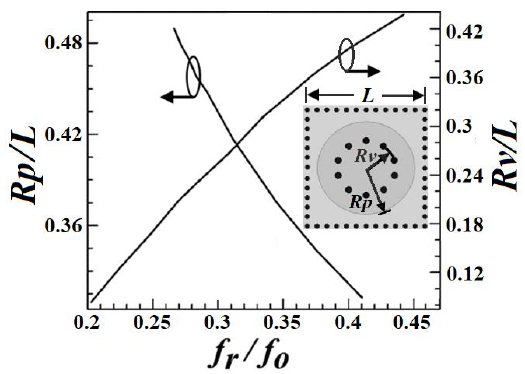
Figure 3. The simulated curves of the normalized resonance frequency f r / f 0 vs. the dimension ratios of R p / L and R v /L (with fixed L = 24 mm).